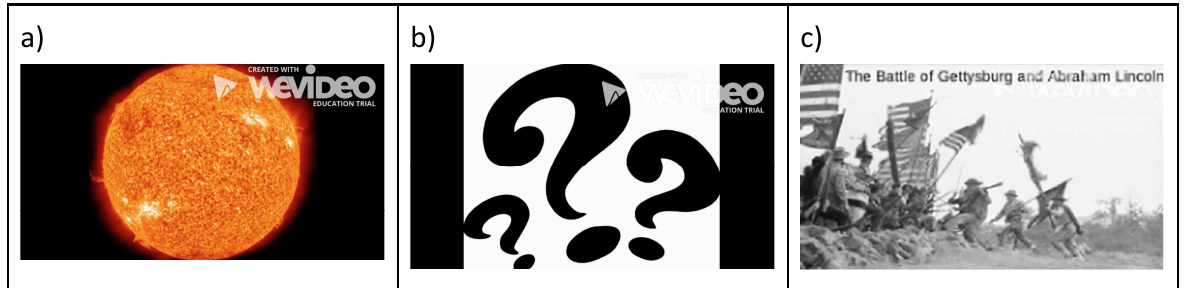
Figure 4 : Screenshot of creating digital story in WeVideo from Clara’s Digital Story